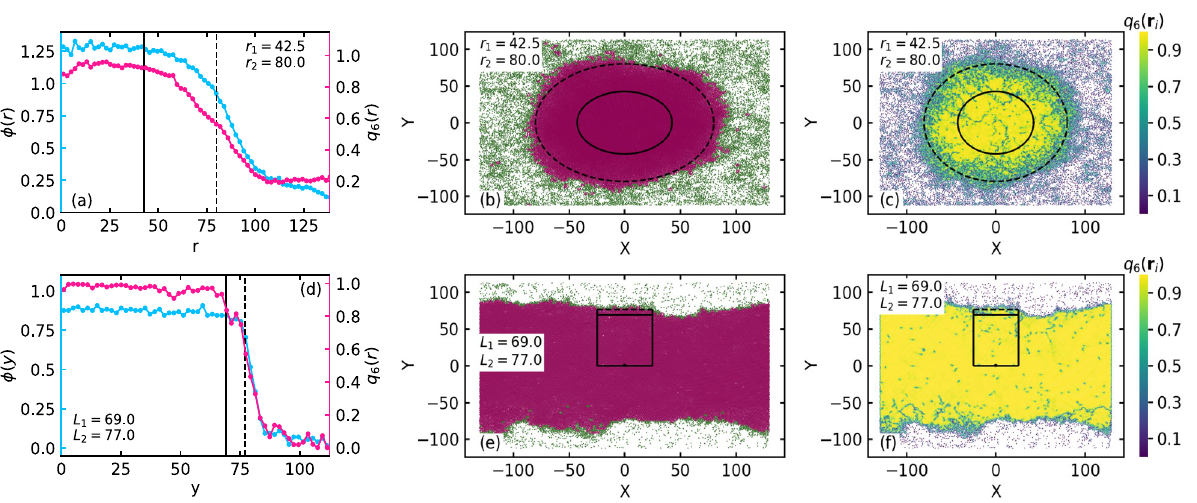
7 (top row) and κ 17 (bottom row) for fixed M 0.05 , J 2 , Figure 3. Local structural properties for κ = = = = 125 . ( a , d ) Local area fraction φ (left vertical axis) and the magnitude of local orientational order q 6 and P e = (right vertical axis) from the center of the high density phase. For calculational ease, the high density phase is shifted to the center of the simulation box. The boundary of the central and the peripheral region are shown by the solid and the dashed line in ( a , d ) (see the main text for definition of central and peripheral region). ( b , e ) Configuration of the system. The disks in the high and the low density phase are colored magenta and green, respectively. Boundary of the central and peripheral region for the circular high density phase is denoted by 42.5 and r 2 80 , respectively, and that for the rectangular high density region is denoted by L 1 69 and r 1 = = = 77 , respectively (see main text for definition of central and peripheral region). ( c , f ) Configuration of the L 2 = system, colored according to the magnitude of orientational order q 6 ( r i ) of the